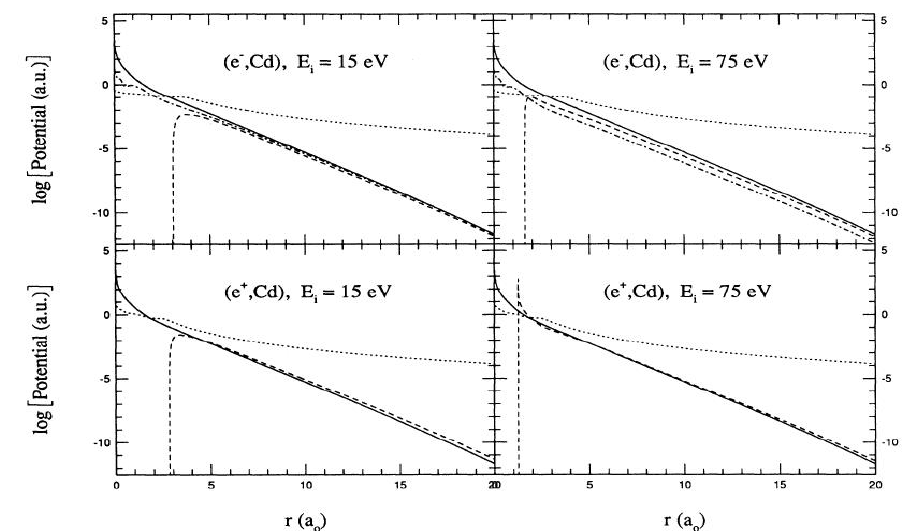
Figure 1. Various interacting potentials, V S (solid), V P (dotted), V ex (dashed) for e ± scattering from Cd showing behaviors at energies of 15 and 75 eV. The curves represent the absolute values of the potentials which are all negative except V S which is positive for electrons